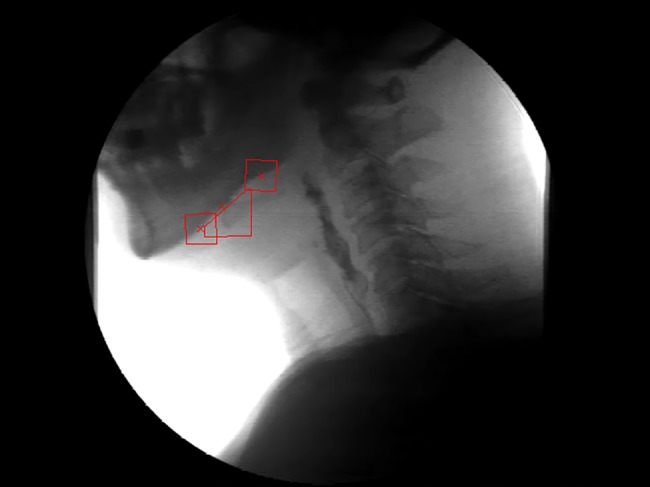
Example of tracking the partly masked ROI.The target point pinpointed by the middle red cross is covered by the mandible in this case. This ROI (the middle square) is cut off by the line segment linked by another two red crosses (their corresponding ROI’s are the upper and lower squares) along the lower edge of mandible.